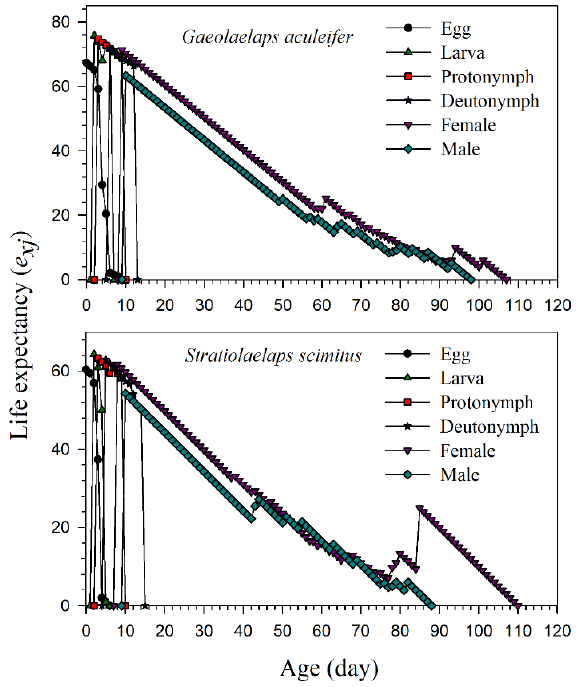
Figure 4. Age-stage-specific life expectancy ( e xj ) of G. aculeifer and S. scimitus fed on T. putrescentiae. The reproductive value ( ν xj ) indicates the expected contribution of an individual of age x and stage j to the future population. The reproductive value gradually increased with an increase in age and stage, whereas the reproductive value of the female stage G. aculeifer and S. scimitus fed on T. putrescentiae were recorded at age 17 d ( v 17,5 = 24.11 d − 1 )